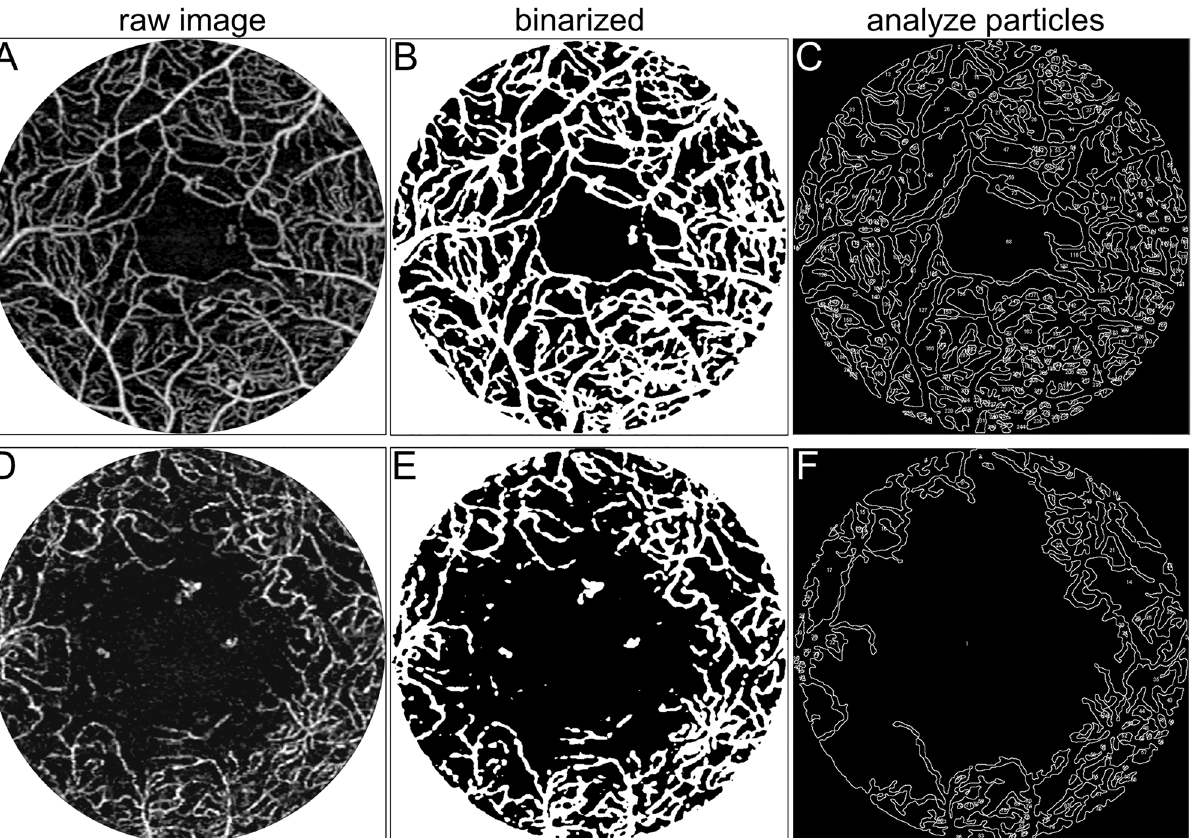
Figure 2. Image processing for the quantification of intercapillary spaces. The binarized image in the central 2 mm circle is applied to the ‘analyze particle’ function in ImageJ, which allows us to measure several parameters of intercapillary spaces. ( A – C ) The software can determine and quantify intercapillary spaces in the two- dimensional network of superficial vessels. The counts, mean area, mean perimeter, mean minimum diameter, and mean maximum diameter of the intercapillary spaces are 243, 6.11 × 10 –3 mm 2 , 0.398 mm, 0.059 mm, and 0.118 mm, respectively. ( D – F ) The three-dimensional structure of the deep vascular plexuses does not allow us to detect such spaces